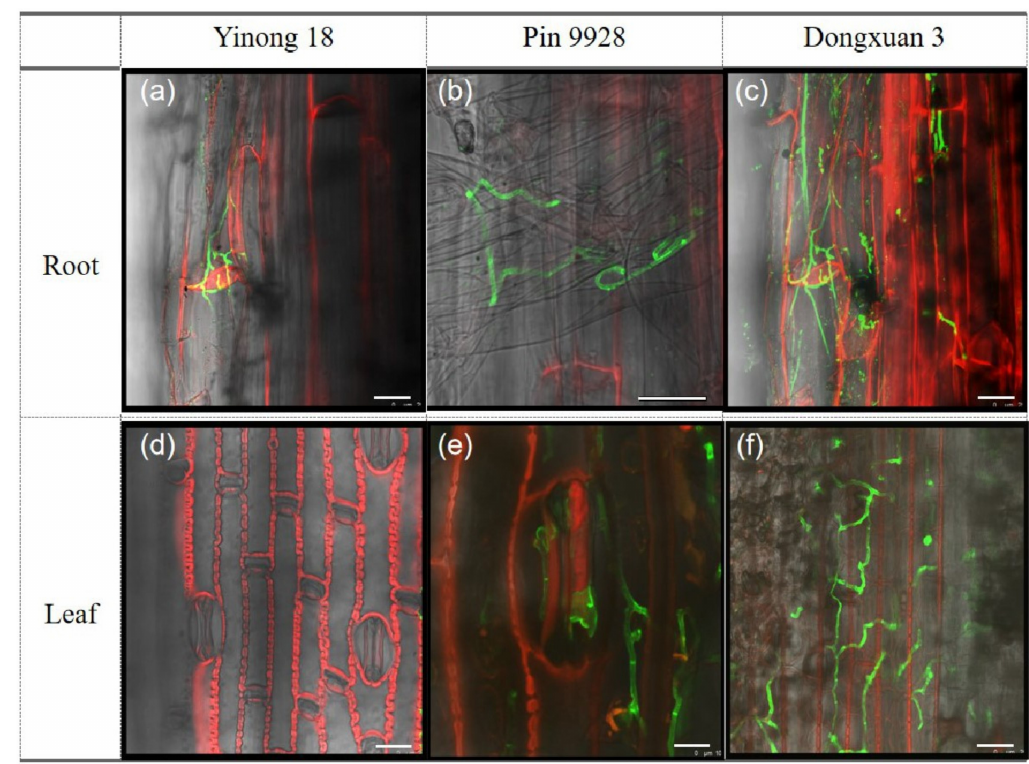
Figure 3. Infestation of T. controversa in wheat roots and leaves as indicated by staining with WGA-AF 488 (for hyphae) and propidium iodide (for roots and leaves cell) ( a ) severity of fungal hyphae in roots of resistant (Yinong 18) cultivar; ( b ) severity of fungal hyphae in roots of moderately resistant (Pin 9928) cultivar; ( c ) severity of fungal hyphae in roots of susceptible (Dongxuan 3) cultivar; ( d ) severity of fungal hyphae in leaves of resistant (Yinong 18) cultivar; ( e ) severity of fungal hyphae in leaves of moderately resistant (Pin 9928) cultivar; ( f ) severity of fungal hyphae in leaves of susceptible (Dongxuan 3) cultivar. Scale bar = 25 µ